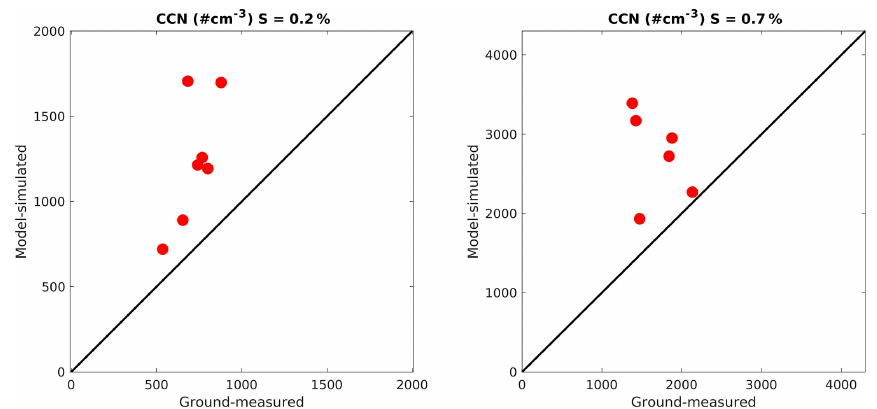
Figure 7. Comparison between model-simulated CCN number concentrations and ground-measured values at the PME station (18.24 ◦ N, 42.46 ◦ E) at supersaturations of 0.2% and 0.7%. The CCN number concentrations correspond to the ground station at Abha. The plotted point represents the average value for different days of measurement from 11–30 August 2009 approximately from 02:00 to